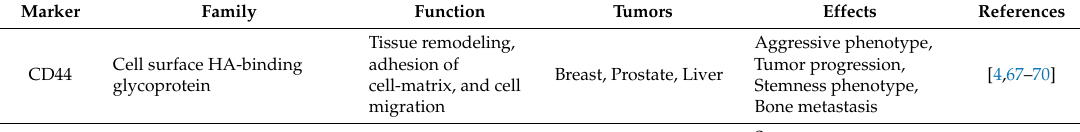
Table 1. Cancer stem cell